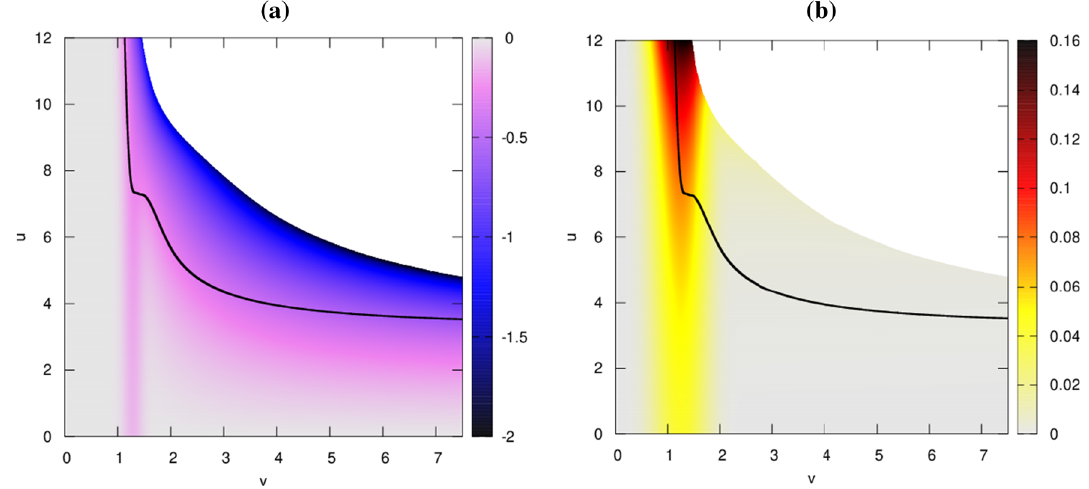
Fig. 12 The (v u ) -distribution of a the neutral scalar field, h , and b the moduli of the complex scalar field, | s | , for the same parameters and field amplitudes as in Fig.